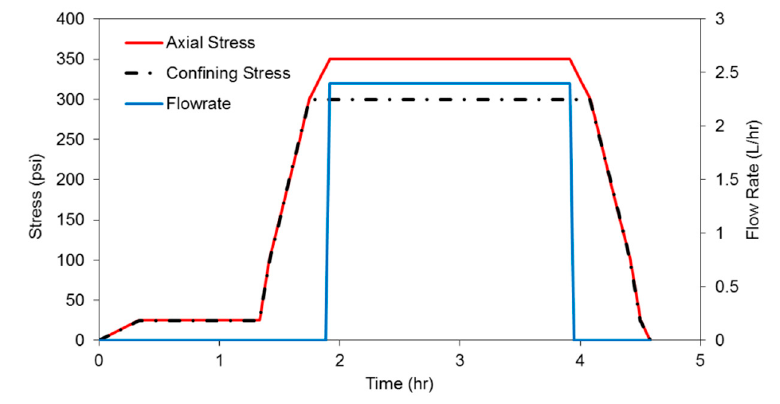
Figure 8. Testing Procedure of 300 psi (2068 kPa) Effective Stress SCT Test.